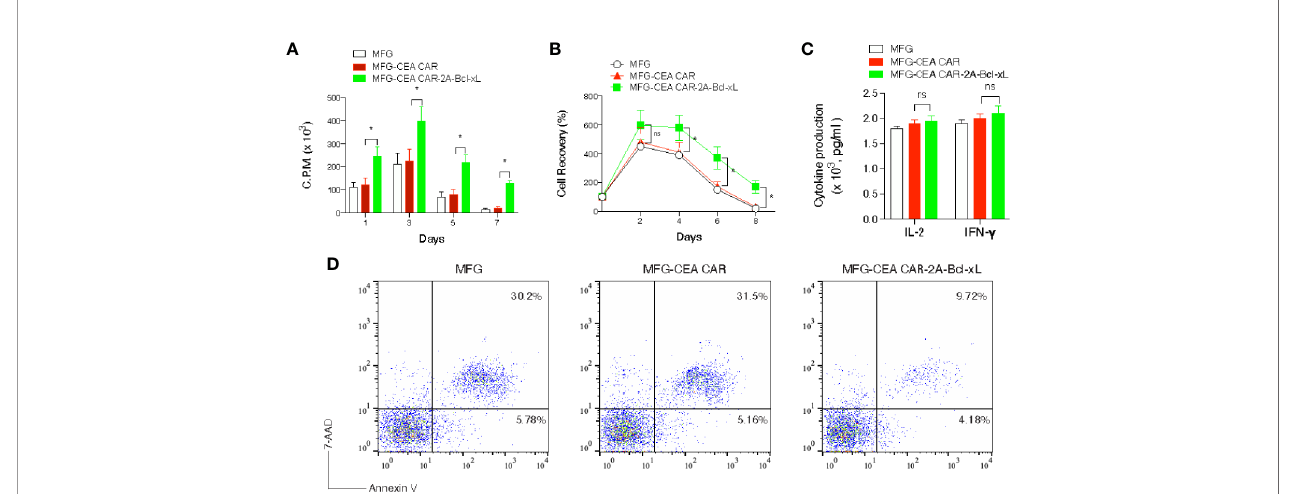
FIGURE 3 | Carcinoembryonic antigen (CEA) chimeric antigen receptor T (CAR-T) cells overexpressing Bcl-xL had a greater recall response in vitro . GFP + CD8 + T cells were sorted ( Figure 2 ) and re-stimulated with anti-CD3 plus anti-CD28 antibodies. (A) Recall proliferation on various days was measured in by pulsing with tritiated thymidine for 20 h. Data are representative with mean ± S.E.M. percentage change from three independent experiments (* P < 0.05, Student ’ s unpaired t -test). (B) Recall survival on various days. The data represent the mean ± S.E.M. percentage change from three independent experiments (* P < 0.05; ns, not signi fi cant, Student ’ s unpaired t -test). (C) Recall IL-2 and IFN- g production by ELISA at 40 h. ns, not signi fi cant. Data are means ± S.E.M. from three experiments. (D) Apoptosis of GFP + CD8 + T cells on day 6 based on staining of Annexin V and 7-AAD and analyzed by fl ow cytometry. Data are representative of three independent experiments.